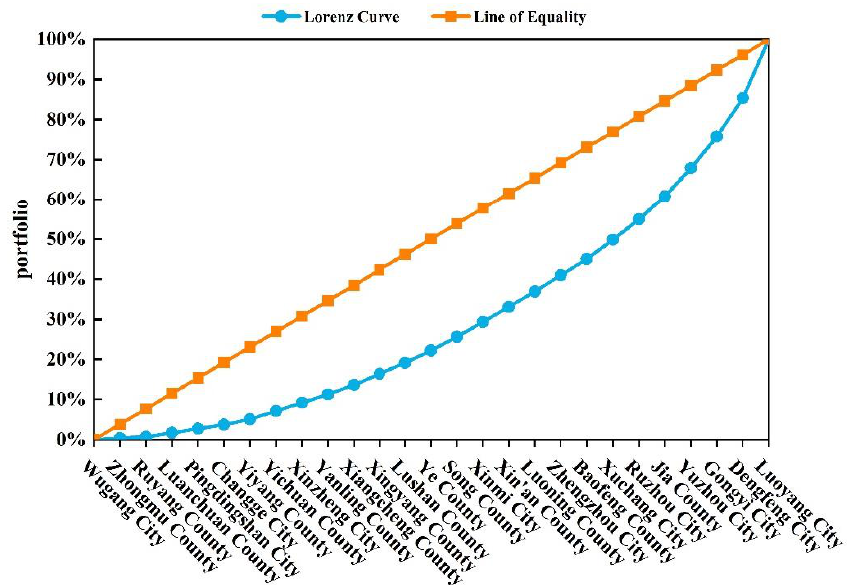
Figure 4. Lorentz curve of spatial distribution of historical buildings in the Songshan region.